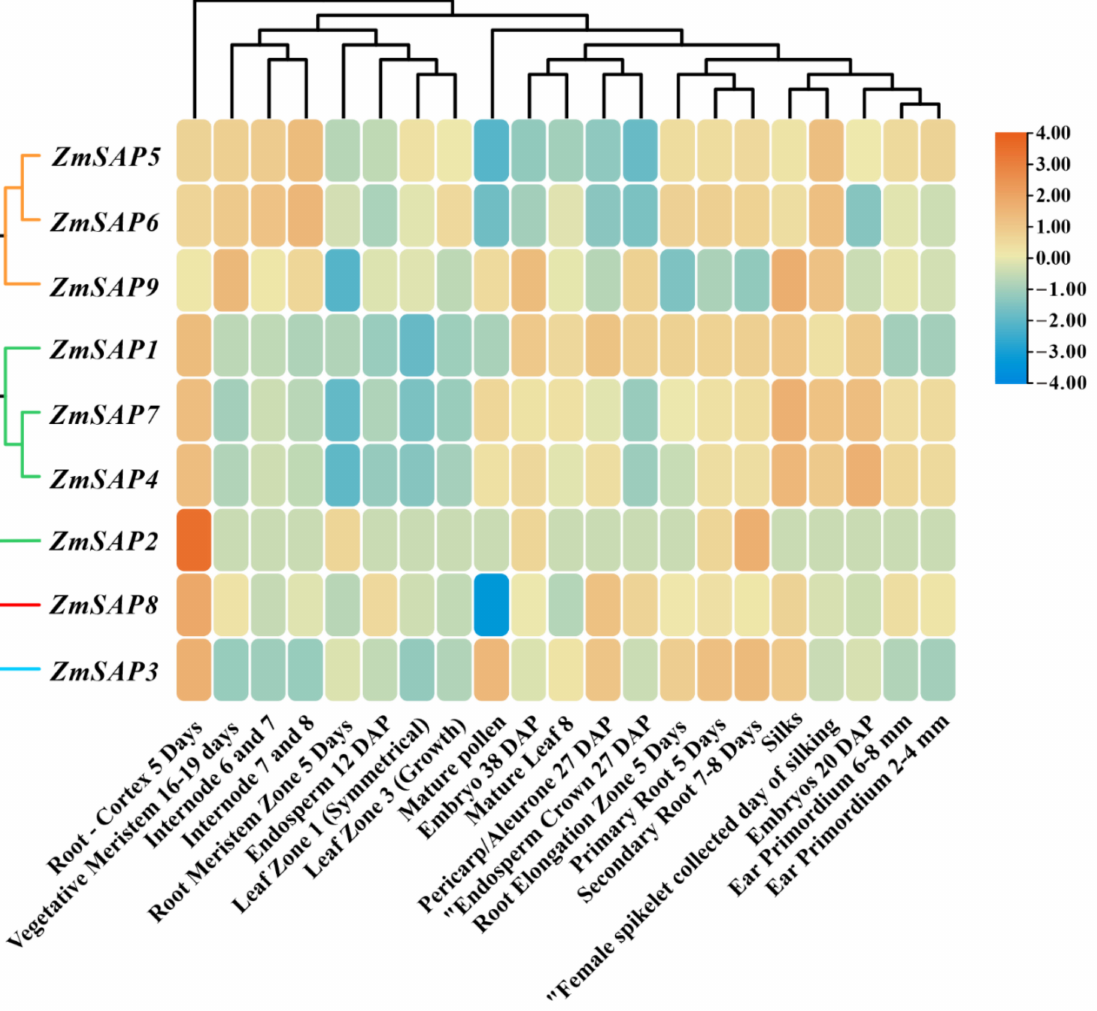
Figure 8. Tissue-specific expression profiles of ZmSAP genes. On the left, blue, red, green, and orange branch represent clade I to V, respectively. Cluster analysis of different tissues is shown at the top of Figure. The values of fragments per kilobase of exon per million fragments mapped (FPKM) were used to represent the expression levels of ZmSAPs in the different tissues. The heat maps were visualized by TBtools